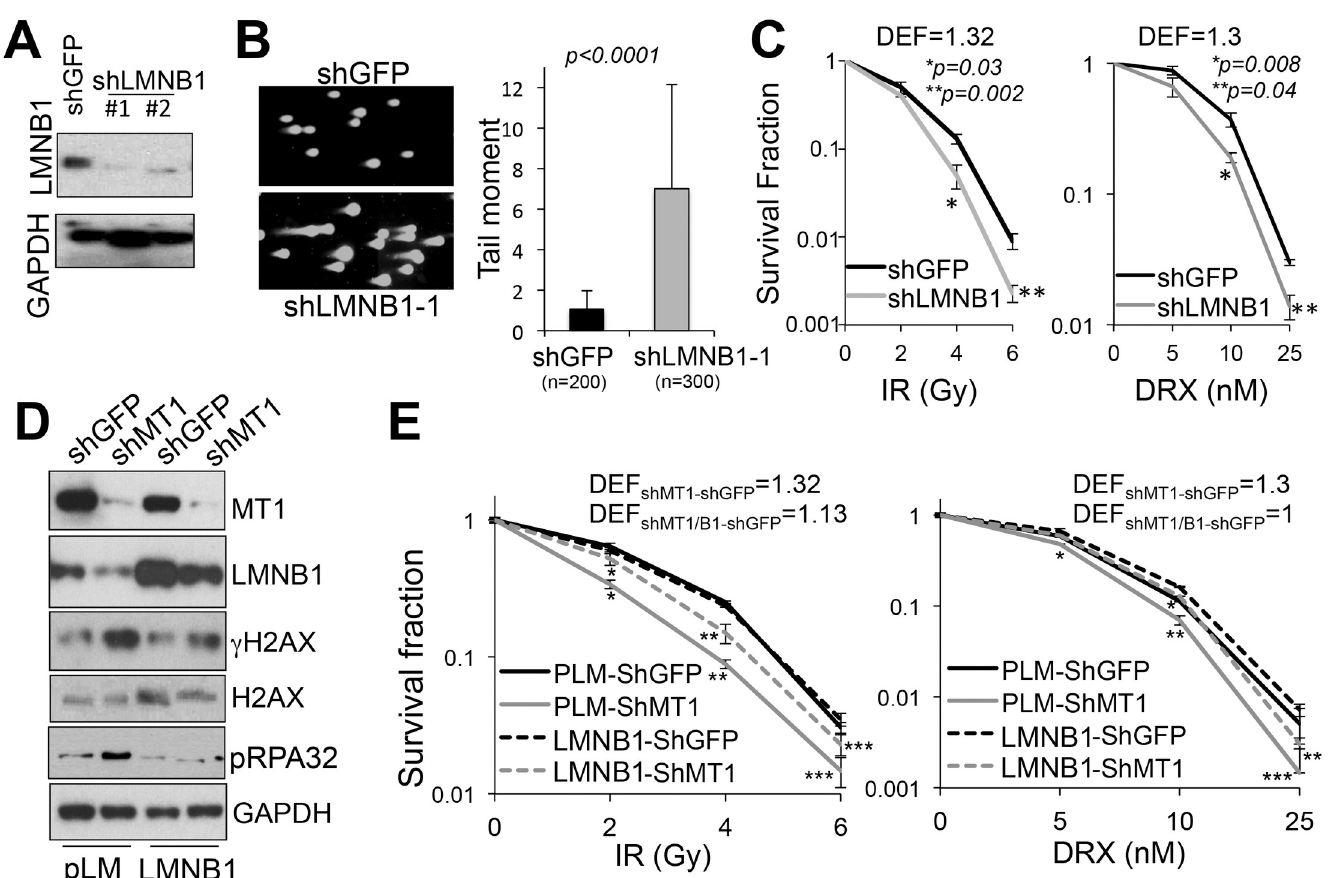
Fig 2. LaminB1 inhibition promotes DSBs and sensitizes to IR and doxorubixn. A) Western blotting of total lysates of MDA-MB-231 cells expressing shGFP or two shRNAs against laminB1. B) Representative picture of a neutral comet assay of MDA-MB-231 cells expressing shGFP or sh-laminB1-1. Tail moment was calculated on at least 50 comets per condition, using Comet Score (TriTek). C) Clonogenic assay of MDA-MB-231 cells expressing shGFP or sh-laminB1-1 treated with IR and DRX for 15 days. DEF (Dose Enhancement Factor) is shown. DEF was determined by the ratio between the radiation or DRX dose alone at 0.1 survival fraction versus radiation or DRX + shLMNB1 at the same survival fraction (DEF > 1 = sensitizer; DEF < 1 = radioprotector). Significant difference between shGFP and shLMNB1 was observed at 4 and 6 Gy IR and 10 and 25 nM DRX, Student’s t test. D) MT1-MMP, laminB1, γ H2AX, total H2AX, phospho-RPA32 and GAPDH levels in cells expressing shGFP or shMT1-MMP and transduced with exogenous laminB1. E) Clonogenic assay of the cells in D treated with IR and DRX for 15 days. DEF is shown. Left panel: � , �� , ��� p < 0.001, significant difference between shGFP and shMT1-MMP was observed at 2, 4, 6 Gy IR; � , �� p < 0.001 and ��� p < 0.01 significant difference between shGFP and shMT1-MMP in which laminB1 was restored was observed at 2, 4, 6 Gy IR. Right panel: � , �� , ��� p < 0.01 significant difference between shGFP